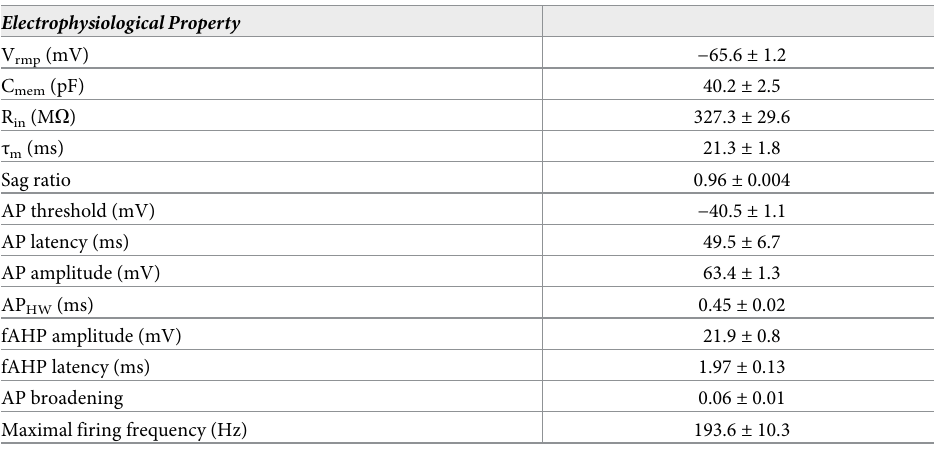
Table 1. Electrophysiological properties of LH PV